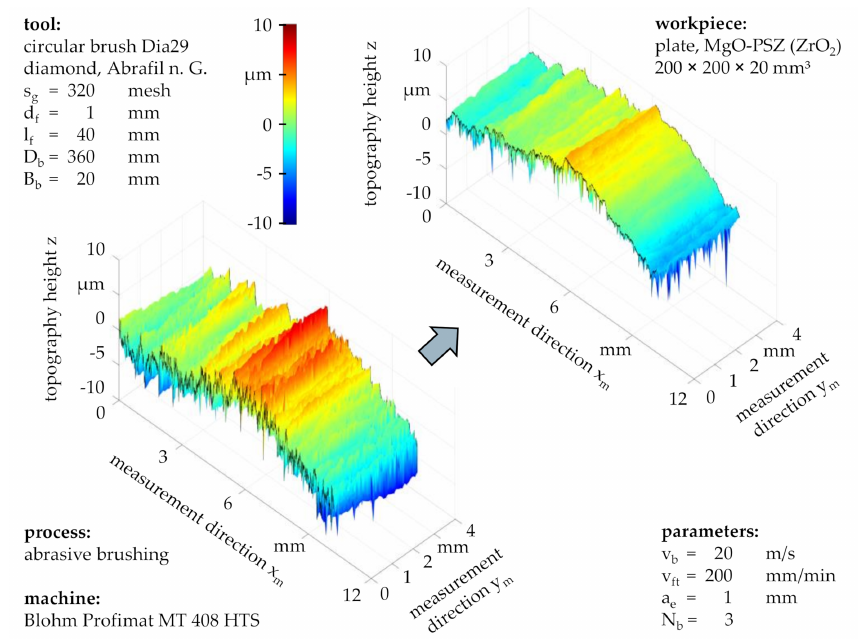
Figure 7. Topography of ZrO 2 , brushed with a grain size of s g = 320 mesh. The comparison between the topography of a workpiece brushed with fine grains with a size of s g = 320 mesh (Figure 7) and the one which was also brushed with standard process parameters but with coarse grains with a size of s g = 80 mesh (Figure 8) suggested that the material removal mechanisms strongly depended on the grain size s g